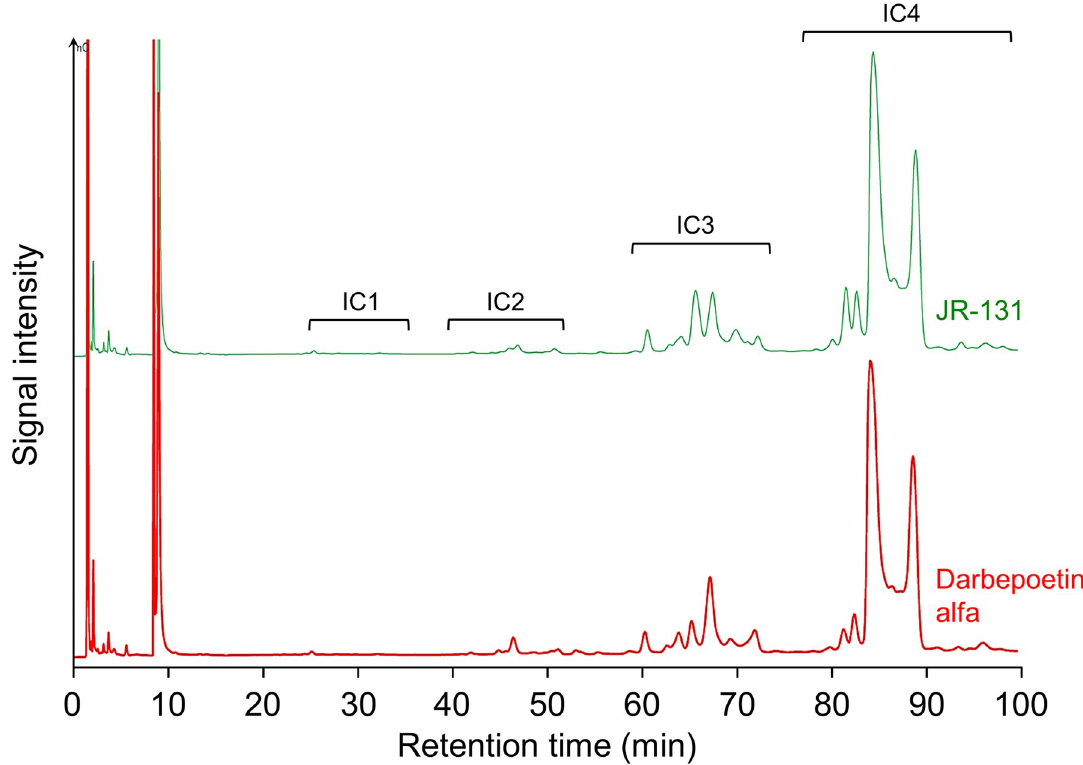
Fig 3. N -linked oligosaccharide profiles of JR-131 and darbepoetin alfa. IC1, IC2, IC3, and IC4 represent monosialo, disialo, trisialo, and tetrasialo sugar chain peak groups, respectively.